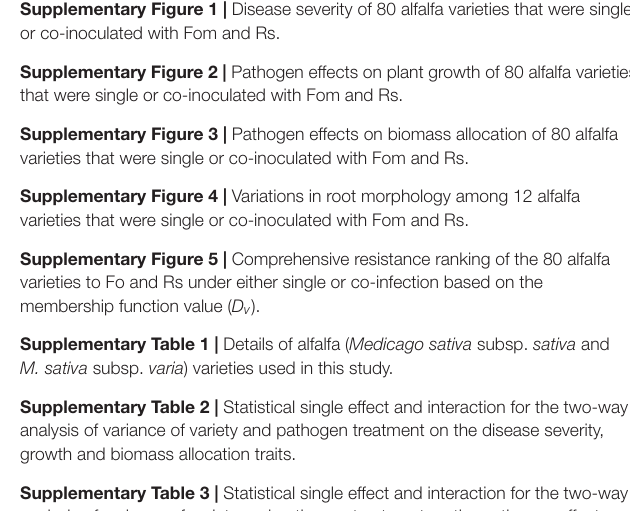
Supplementary Table 2 | Statistical single effect and interaction for the two-way analysis of variance of variety and pathogen treatment on the disease severity, growth and biomass allocation traits. Supplementary Table 3 | Statistical single effect and interaction for the two-way analysis of variance of variety and pathogen treatment on the pathogen effect sizes of growth and biomass allocation traits. Supplementary Table 4 | Pearson’s correlation matrix for the disease severity index and pathogen effect sizes of growth and biomass allocation traits across 80 alfalfa varieties that were single or co-inoculated with Fom and